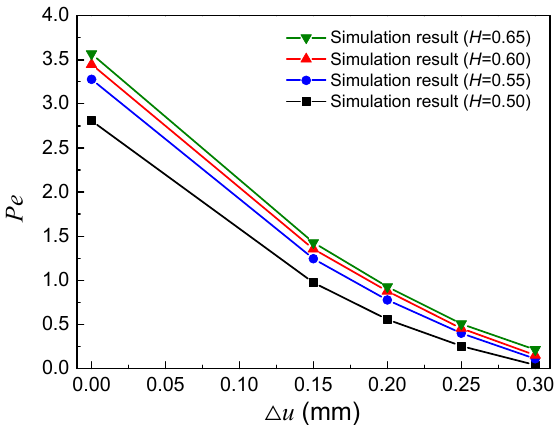
∆ u for all numerical simulation